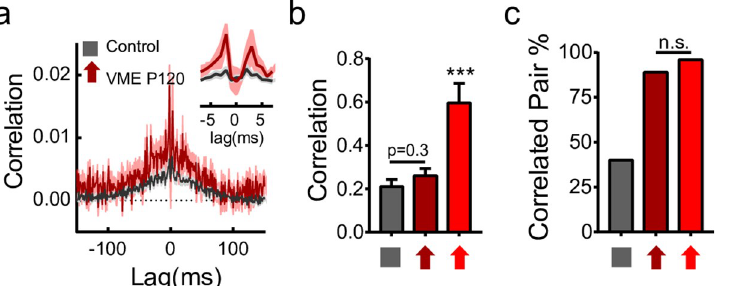
Fig 5. Effects of upward VME are long-term. (a) Comparison of V-DSGC cross-correlograms between control and upward gratings VME 3 months after training. Cross-correlograms of V-DSGC pairs within 250 μ m of each other are averaged. Control, gray, n = 75; upward VME at P120, dark red, n = 9. Shaded areas, ± SEM. (b) Quantification of correlation for close V-DSGC pairs based on (a). Control, gray, n = 75; upward VME at P120, dark red, n = 9; upward VME, red, n = 24. Correlation was computed as in 2b. ��� p < 0.001, unpaired t test. Error bars, SEM. (c) Proportion of close V-DSGC pairs that are significantly correlated. Color codes and n values are the same as in (b). Chi-squared test, p = 0.89, comparing upward VME recorded at P120, with upward VME recorded right after training. To test the effect of the smaller sample size of the P120 group, we randomly chose 9 pairs from the regular VME group and compared with the P120 group. This was repeated 1,000 times. In 100% of cases, no significant difference was detected between the two VME groups. Data for this figure are in S5 Data. n.s., not significant; V-DSGC, ventral-preferring direction selective ganglion cell; VME, visual motion